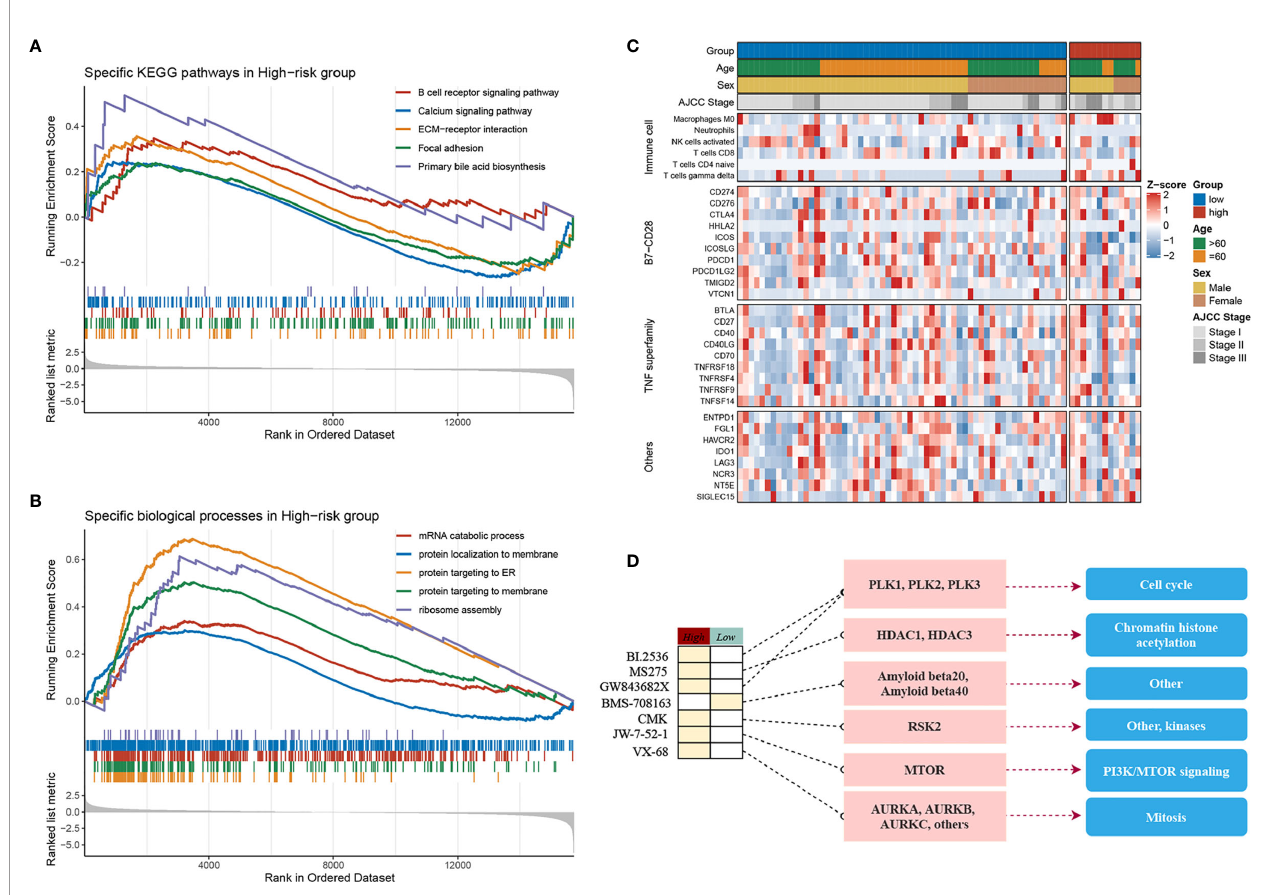
FIGURE 4 | Molecular landscape, immune landscape, and assessment of chemotherapy. (A, B) The GSEA analysis of the high- and low-risk groups. (A) The KEGG pathway enrichment analysis and (B) The biology process enrichment analysis. (C) The heatmap of the clinical- and immune-related molecular landscape. From the top to the end, there are fi ve models, including clinical characteristics, immune cells, B7-CD28, TNF superfamily, and other immune-related molecular landscapes. (D) Molecular regulatory mechanism of the seven potential antitumour drugs. Left, the drug names and the level of sensitivity in each group; middle, the drug- targeted molecules; right, the drug-targeted